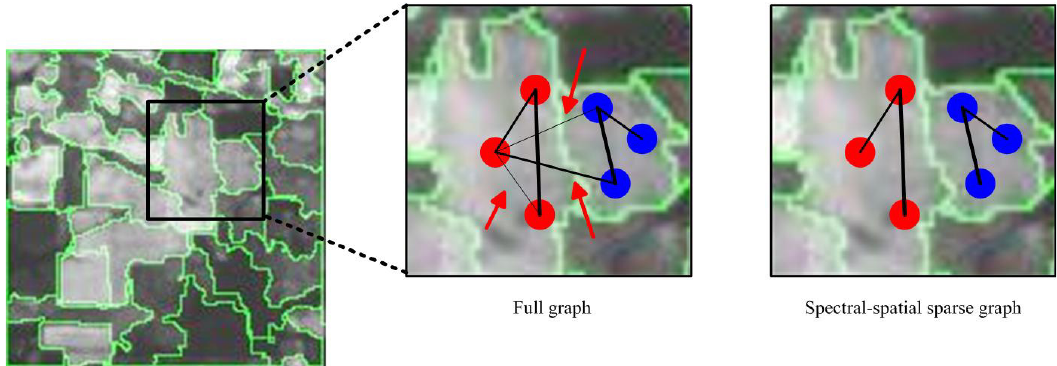
Figure 3. The graphical illustration of spectral–spatial sparse graph. In a full graph, vertexes are densely connected with others. In a spectral–spatial sparse graph, vertexes are sparsely linked with those pixels that are located in the same homogeneous regions. The links between different homogeneous regions and some weak links marked with red arrows are removed from the full